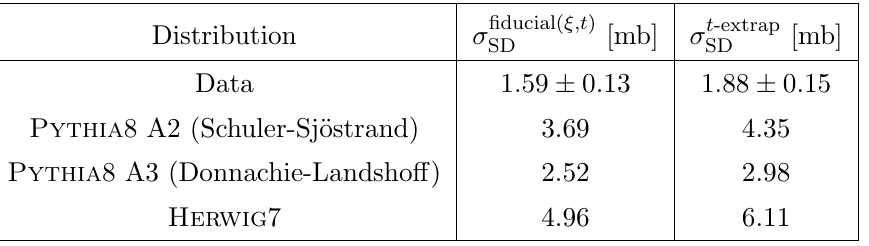
(cid:24) (cid:20) (cid:0) 1 : 6 and 0 : 016 < j t j (cid:20) 10